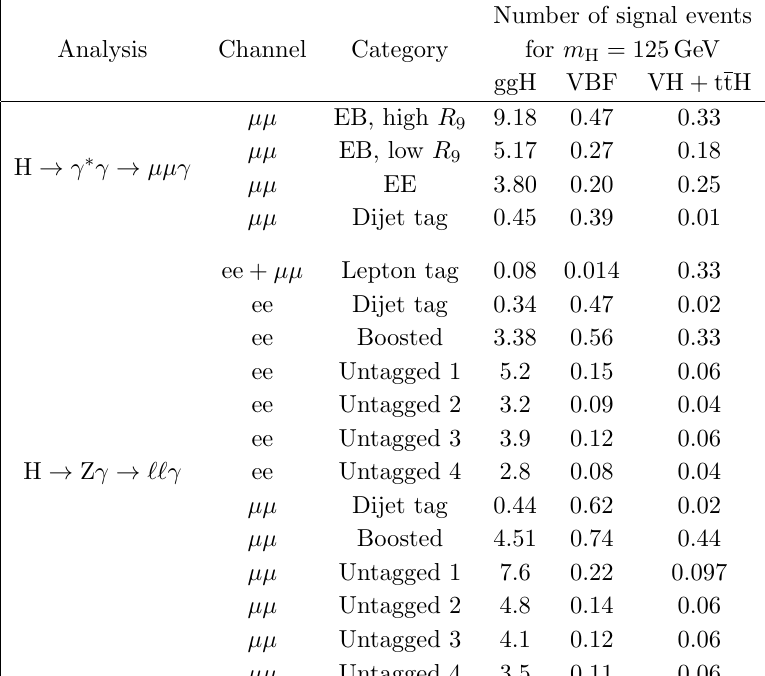
Table 2 . Expected signal yields for a 125 GeV SM Higgs boson, corresponding to an integrated luminosity of 35.9 fb (cid:0) 1 , for all categories in the H the narrowest ‘‘(cid:13) invariant mass window around 125 GeV containing 68.3% of the expected signal